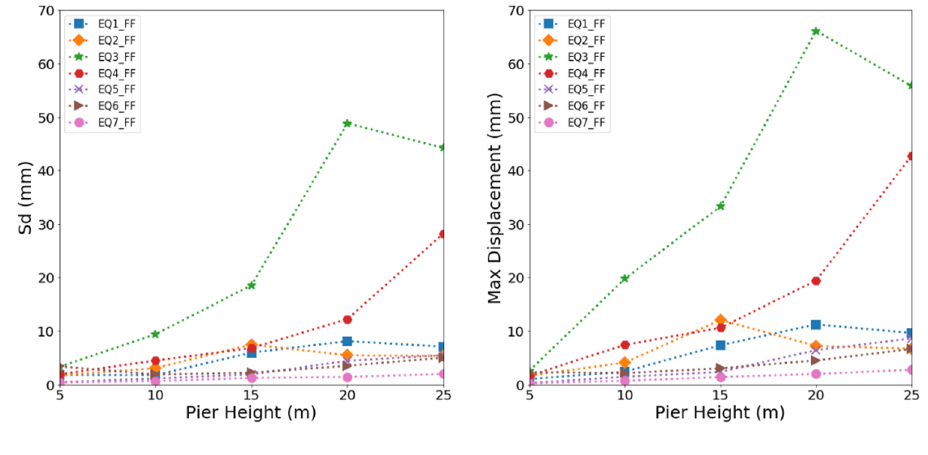
Figure 12. Relationship of the displacement spectrum (S d ) and maximum lateral displacement with the pier height for far-fault ground motions: ( a ) Displacement spectrum at far-fault ground motion; ( b ) maximum displacement at far-fault ground